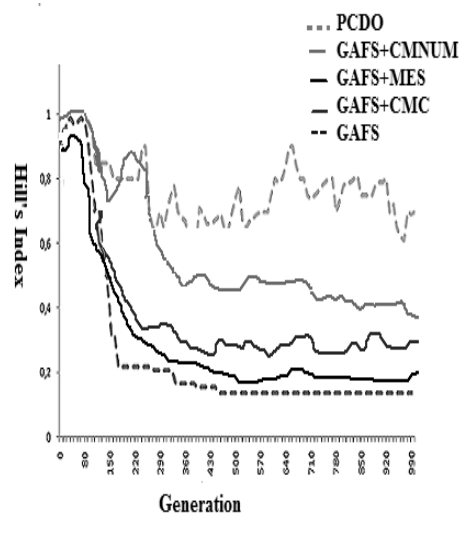
Fig. 5. PCDO examined with some functionality turned